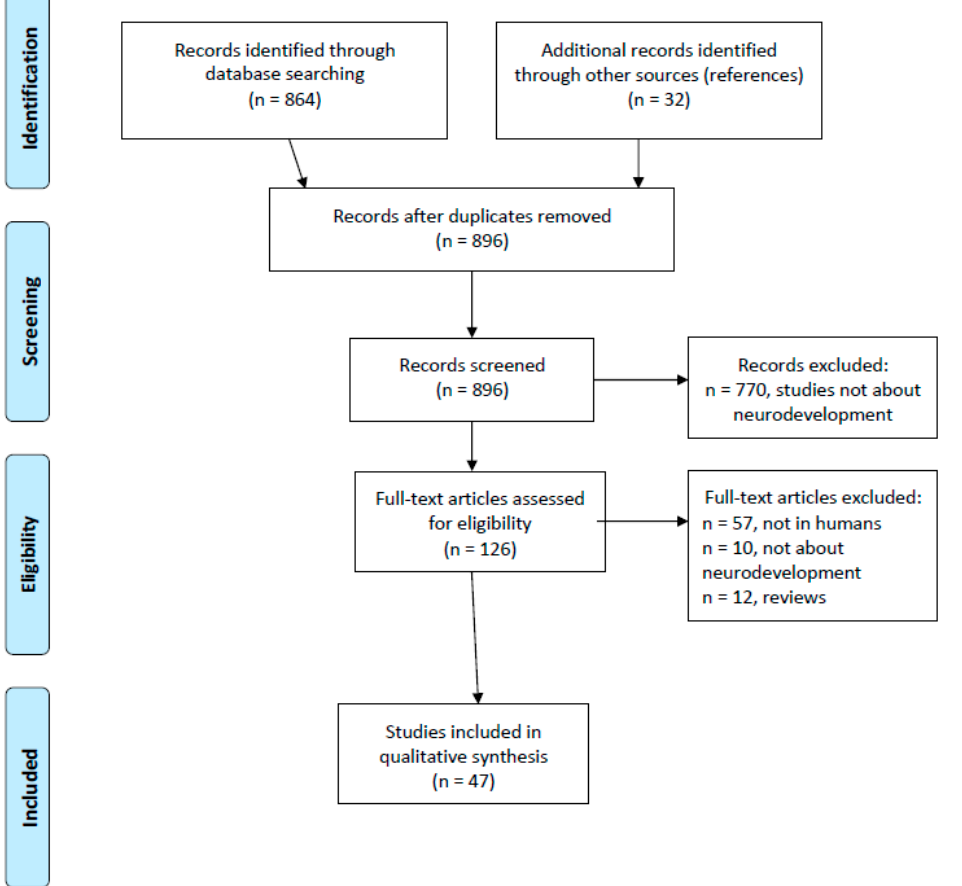
Figure 1. PRISMA flow diagram. Source: Moher D. et al., the PRISMA group (2009) [22].